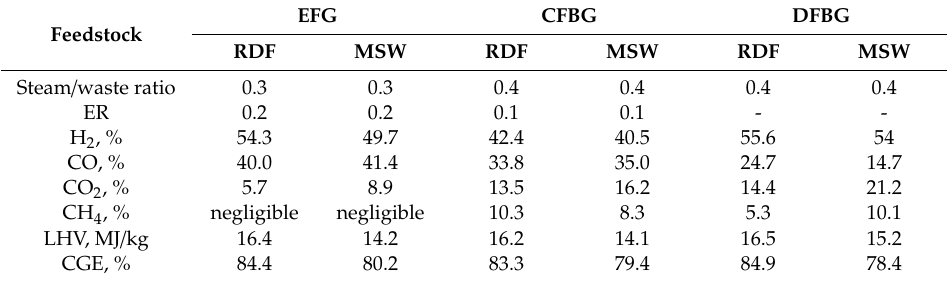
Table 2. Volumetric composition of syngas from gasifiers (the EFG, CFBG and DFBG) for both MSW and RDF gasification selected for heat, power and biofuel synthesis in polygeneration cases 1 to 4.